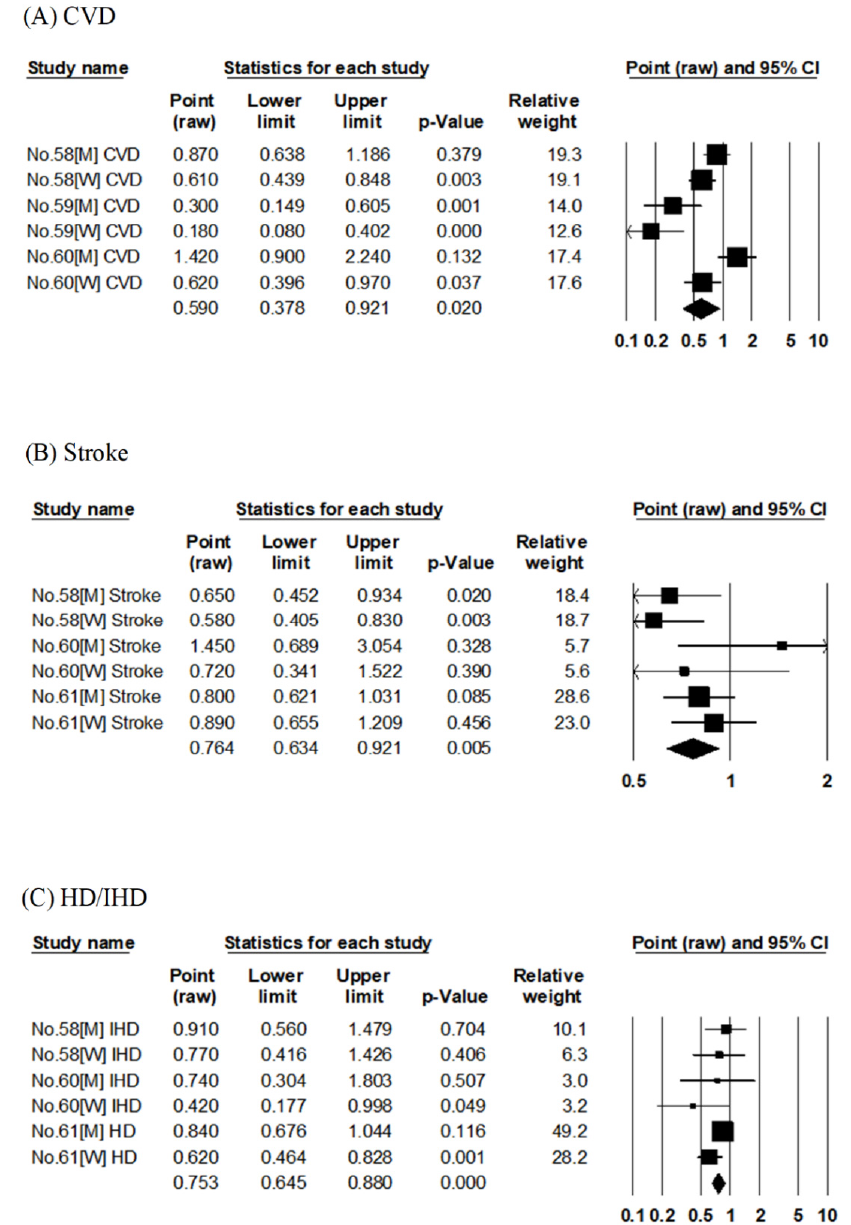
lowest consumption of green tea was 0.75 (95% CI: 0.65–0.88, p < 0.001, I 2 = 1%, Egger’s test: p = 0.515), indicating a reduced risk of HD/IHD mortality in the group with the high- est consumption of green tea (Table 2, Figure 6C).